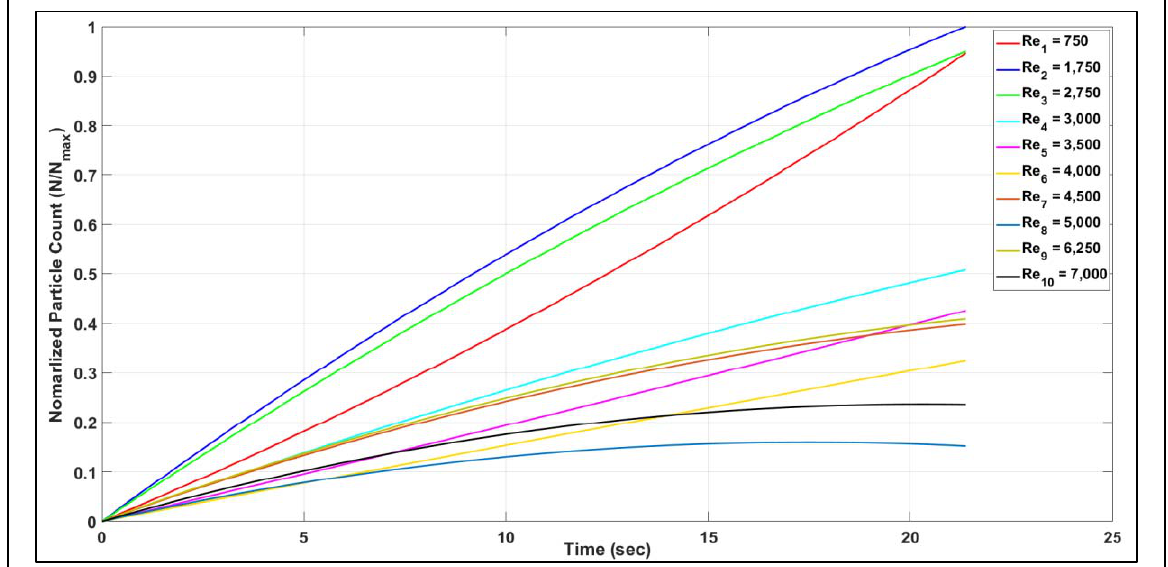
Figure 4. Normalized Particle Count Over Time for 10 Reynolds